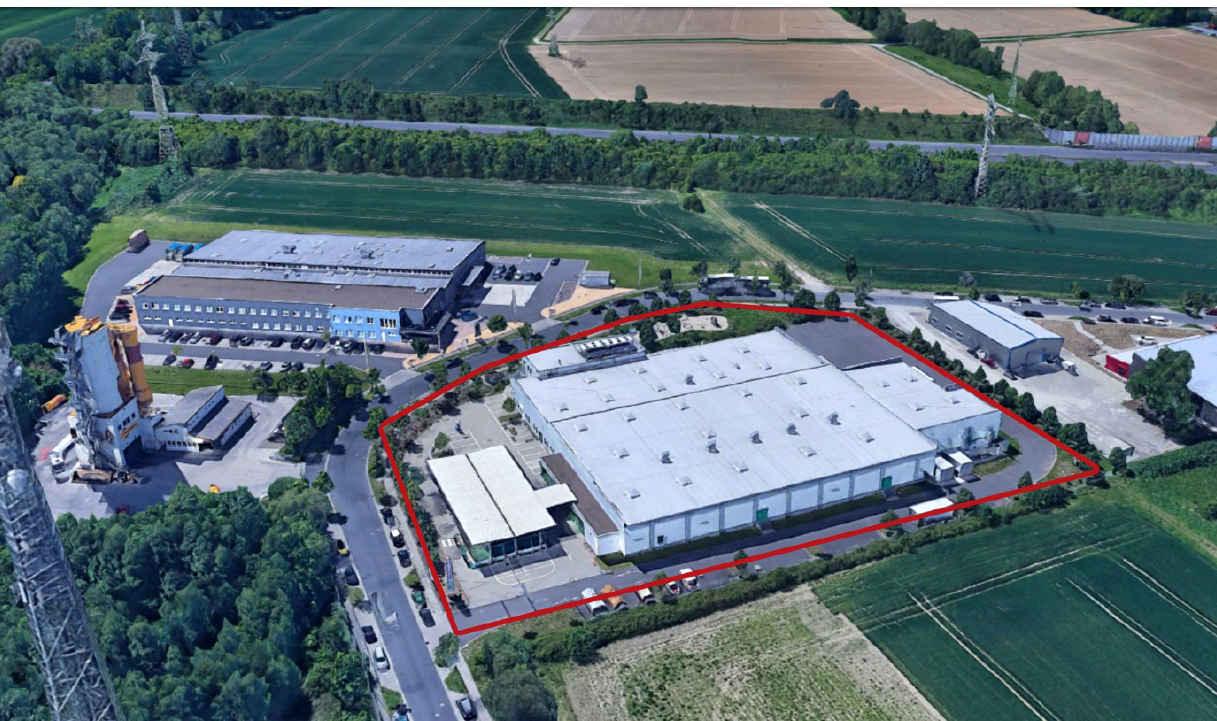
Figure 6. Former market hall transformed into a refugee accommodation for 400 persons. Most recently, it has been used for rejected or tolerated asylum-seekers or those with a low recognition profile. The structure located in an industrial area is close to the highway and has no windows. The next figure illustrates the interior. Source: author. Aerial view from